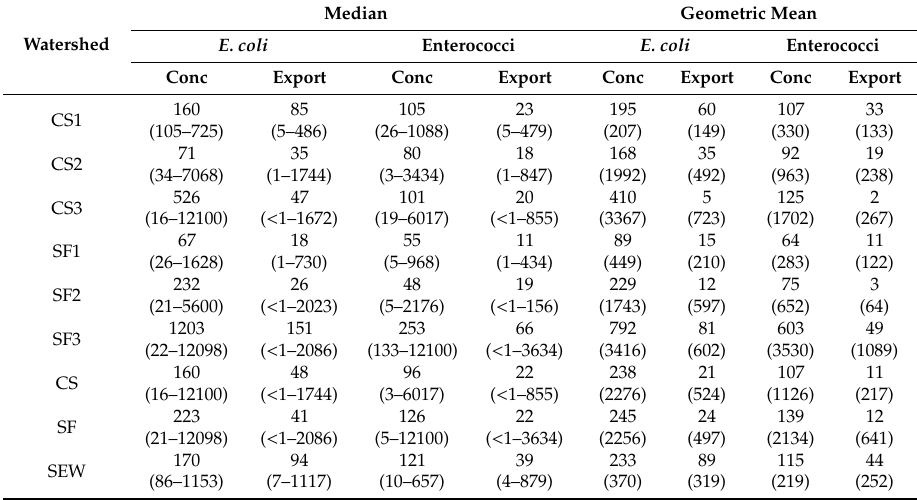
Table 2. Median and geometric mean concentrations (MPN 100 mL − 1 ) and exports (MPN s − 1 ha − 1 ) of fecal indicator bacteria for the studied watersheds. For median values, the range is included in parentheses. For geometric mean values, the standard deviation is included in parentheses. Conc = concentration; CS = conventional septic; SF = sand filter; SEW = sewer.